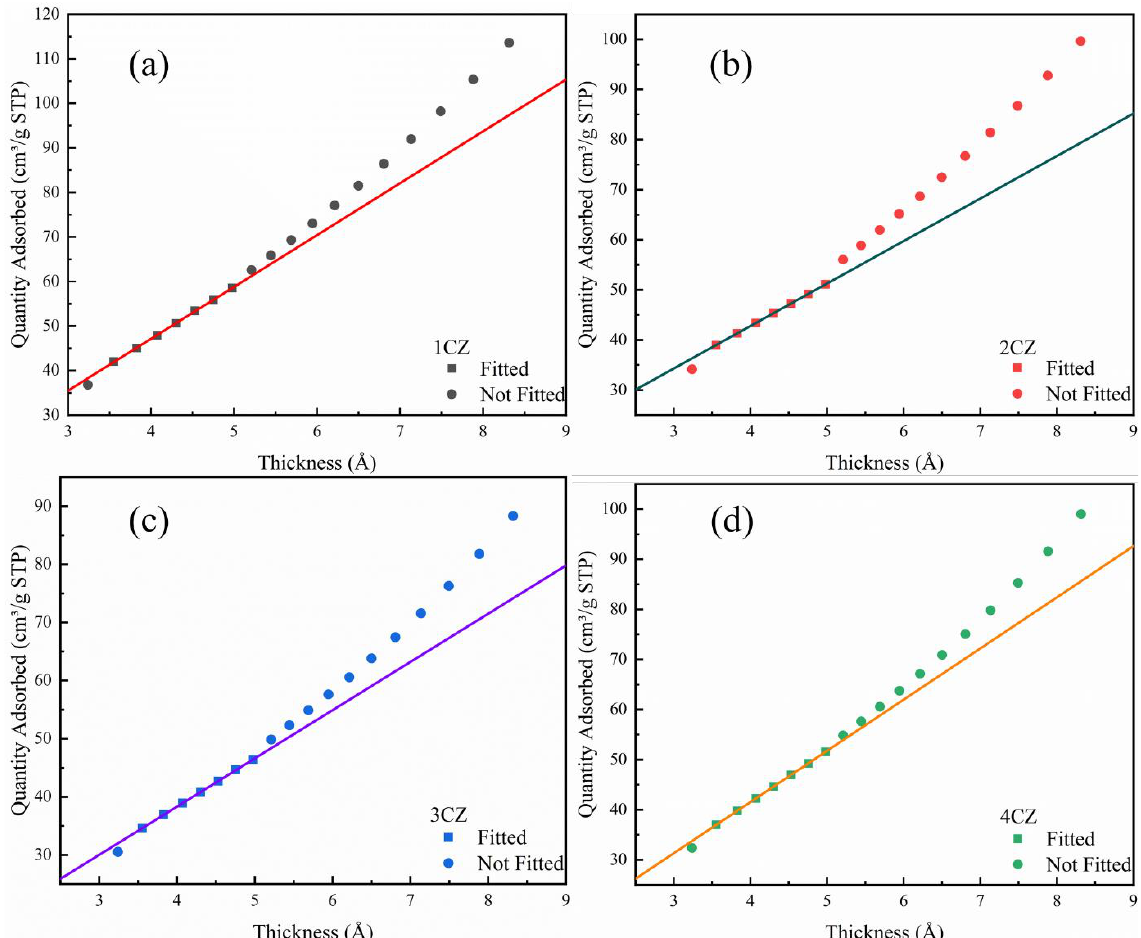
Figure 9. t-Plot for the CZ nanoparticles, ( a ) 1CZ; ( b ) 2CZ; ( c ) 3CZ; ( d ) 4CZ. Table 4. t-Plot micropore volume and BJH mesopore volume for the CZ nanoparticles.